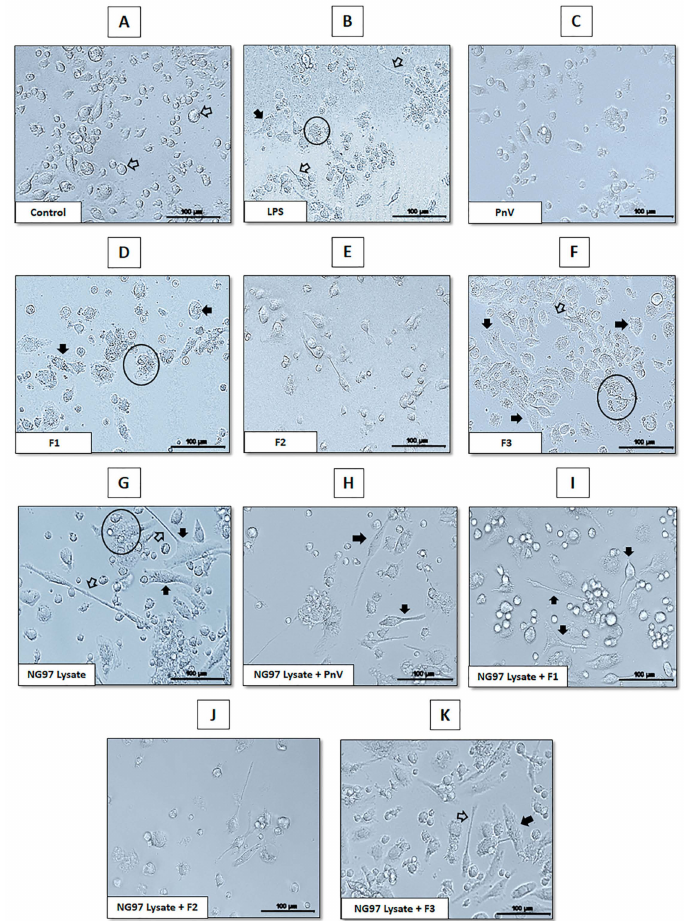
Figure 5. Analysis of morphological changes in DCs. Representative panels of morphological anal- ysis of DCs treated for 24 h with PnV (14 µ g/mL) or its isolated molecules (1 µ g/mL), with or without simultaneous stimulation with glioblastoma cells (NG97) lysate. Signs in panels indicate morphological changes compared to the untreated control (panel ( A )). ( B – K ) represent all treat- ments, as indicated in each panel. Filled arrows: irregular bodies; unfilled arrows: processes; circle: cells with granular cytoplasm. Morphological analyses were made using the Cytation-5 (BioTeK). Bars = 100 µ